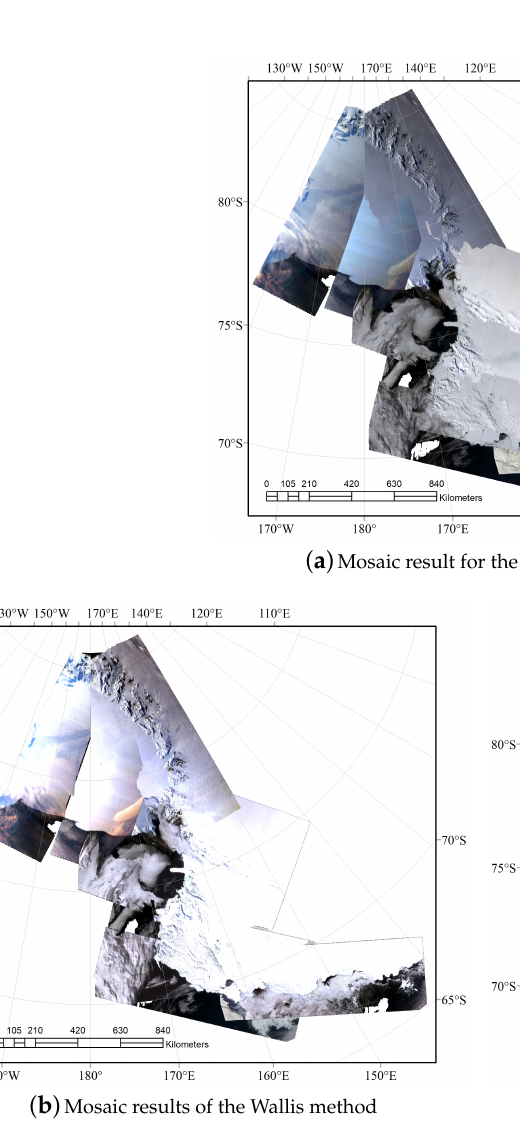
Figure 12. Comparison of the mosaic results for the group images processed by the Wallis method [12] and the proposed approach. ( a ) Mosaic results for the original images. ( b ) Mosaic results for the images processed by the Wallis method. ( c ) Mosaic results for the images processed by the proposed